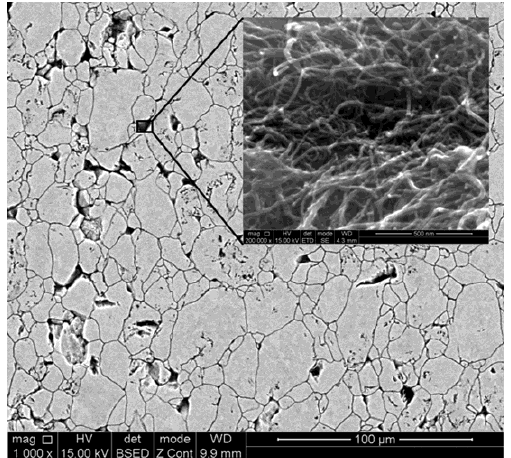
Figure 4. SEM image of the Al/CNT nanocomposites produced with 1.00 vol % of CNTs .